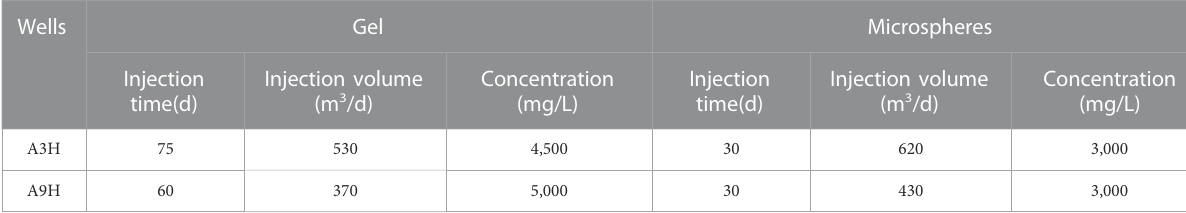
TABLE 8 Injection parameters of pre